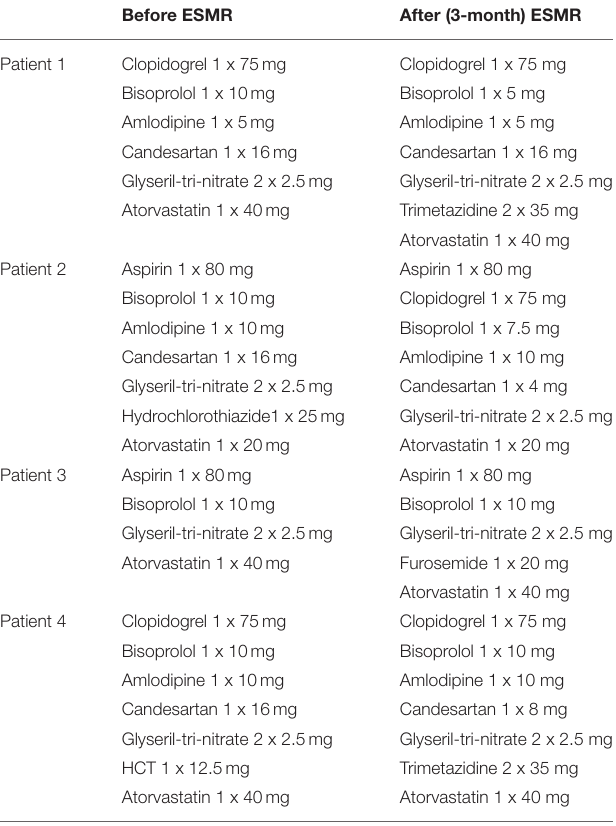
TABLE 2 | Medications history of included